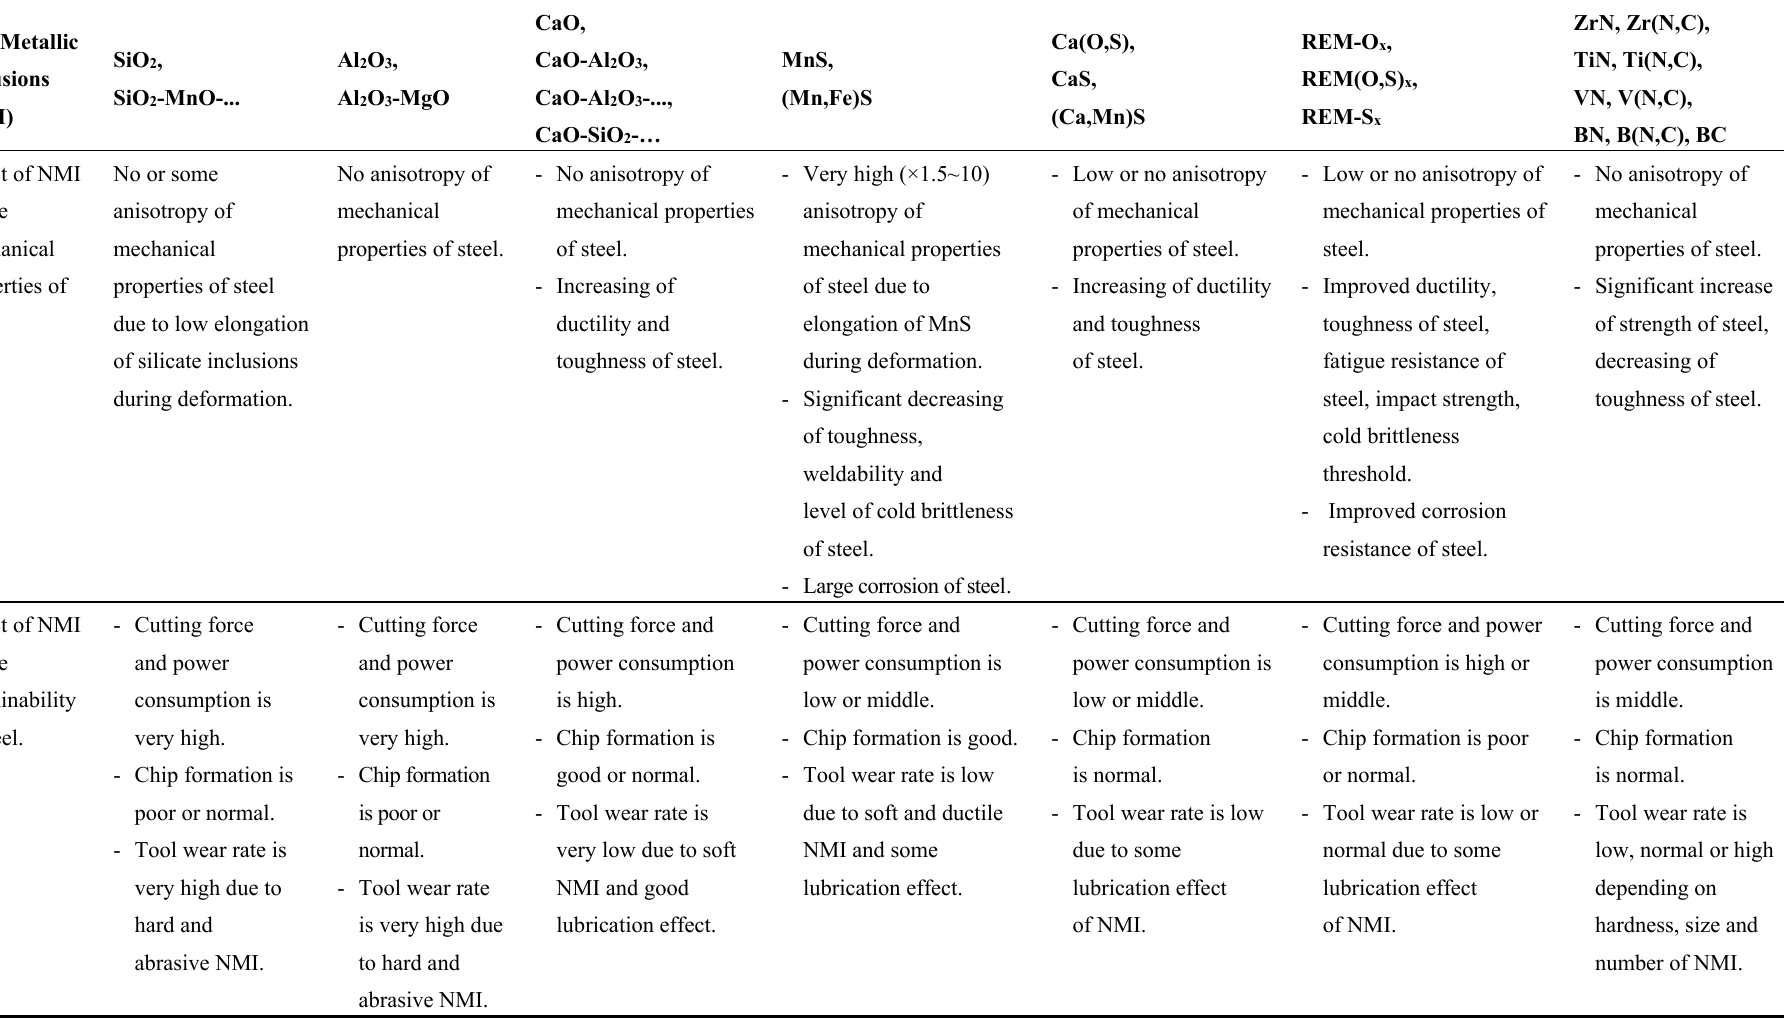
Table 3. Qualitative influence of different non-metallic inclusions (NMI) on some mechanical properties and mechanical machinability of